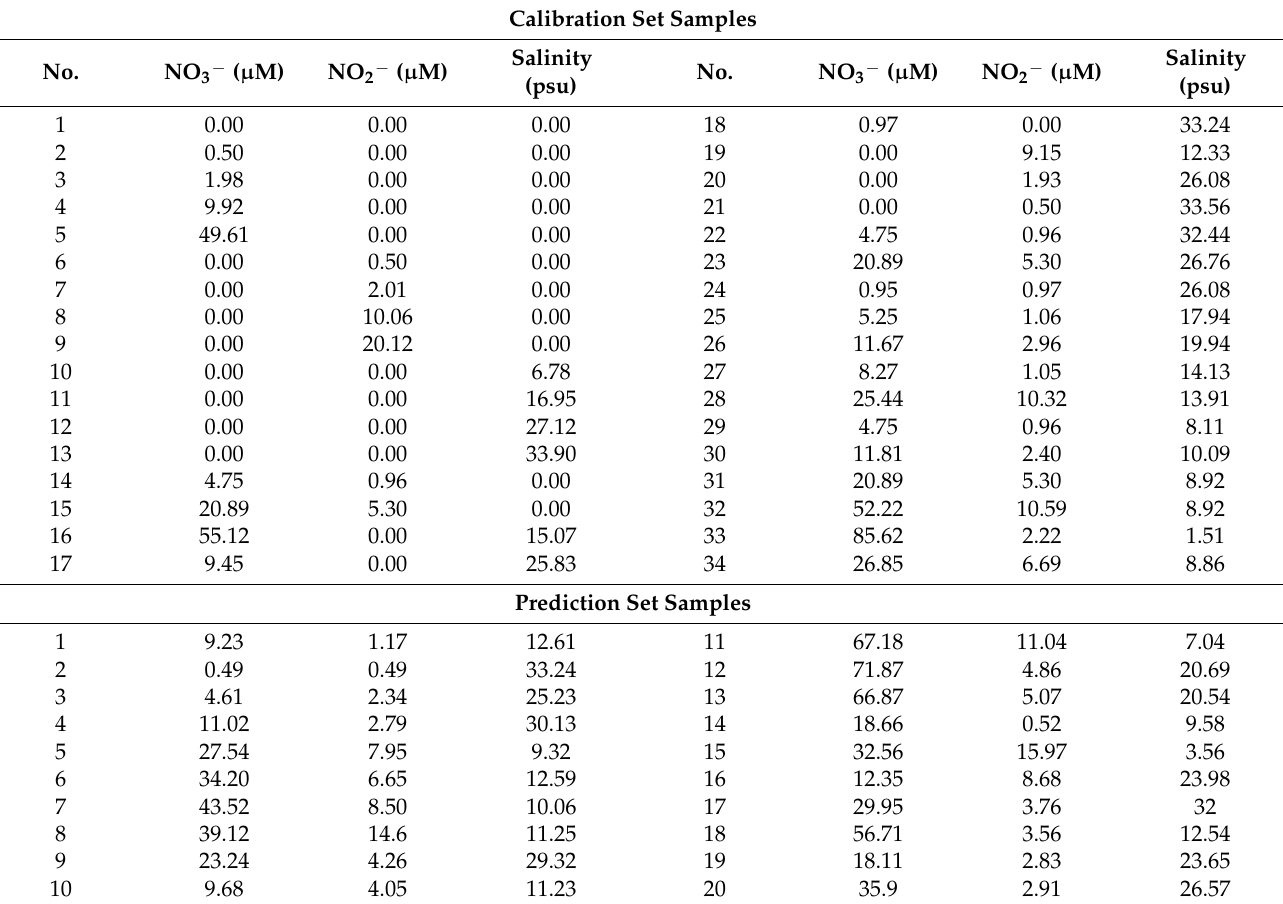
Table 1. Composition of the calibration and prediction